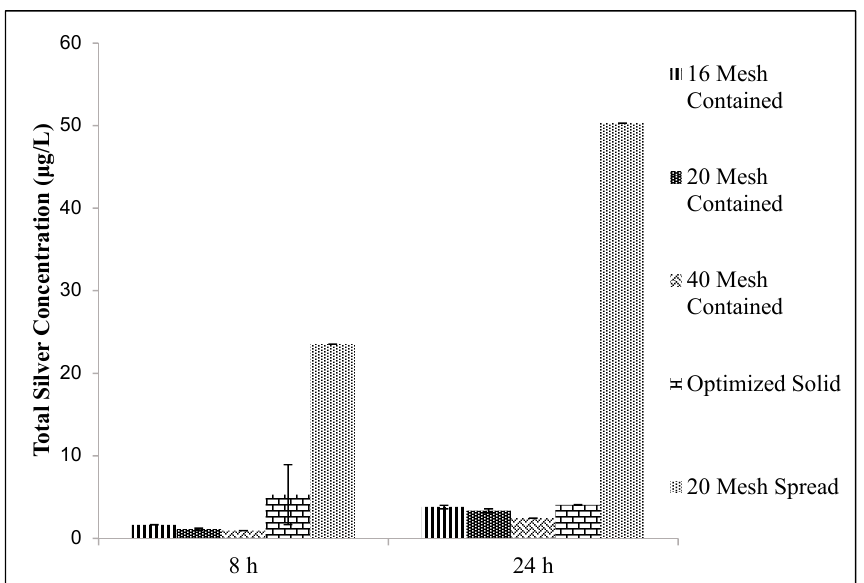
Figure 5. Total silver concentration of 10 grams of crushed clay tablets in 300 mL of tap water (equivalent to approximately two solid tablets containing 1g of silver each in 10 L) after 24 hours as a function of the particle mesh size. Error bars represent standard error. Last bar represents the the theoretical silver release after 24 hours of two solid tablets embedded with 1 g of silver each, made using the optimized firing protocol and compression pressure, in 10 L of tap water.